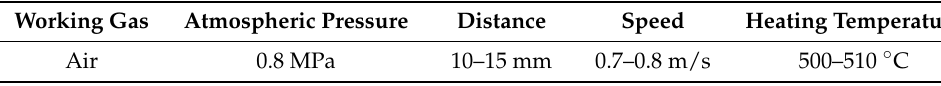
Figure 1. Particle-size distributions of the cold-spraying powders. Table 1. Processing parameters of the cold-spraying equipment.